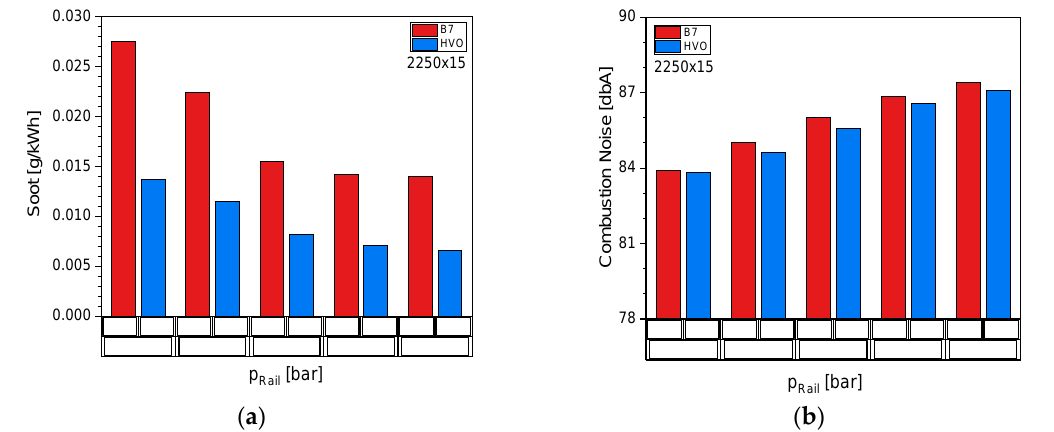
Figure 6. Influence of p rail on soot ( a ) and combustion noise ( b ) for diesel and HVO at 2250 × 15.